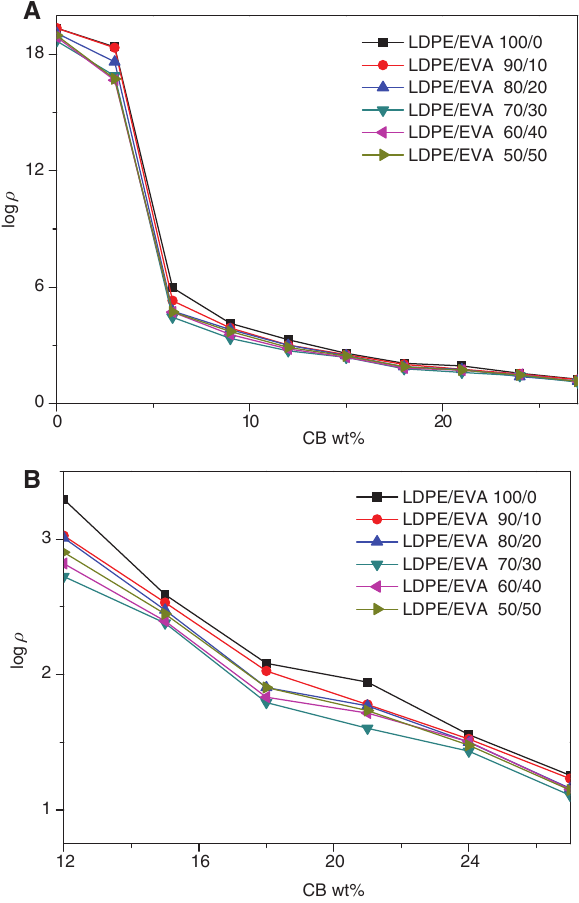
Figure 1: The composites resistivity with different EVA contents: (A) Composites resistivity vs. CB content; (B) Composites resistivity vs. CB content from 12% to